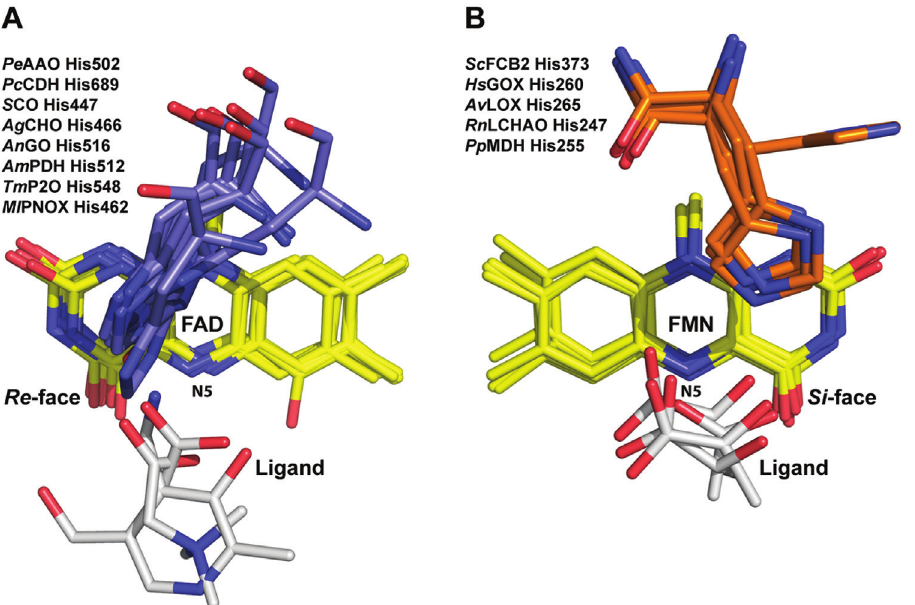
Figure 3 Superimposition of the active sites of representative members of the GMC oxidoreductase superfamily (A) and the LHAD family (B) showing the position of the fully conserved histidine and various ligands. The figure was drawn by using the PDB files 3FIM, 1KDG, 1B4V, 4MJW, 1CF3, 4H7U, 1TT0, 4HA6, 1FCB, 2RDU, 2NLI, 1TB3, and